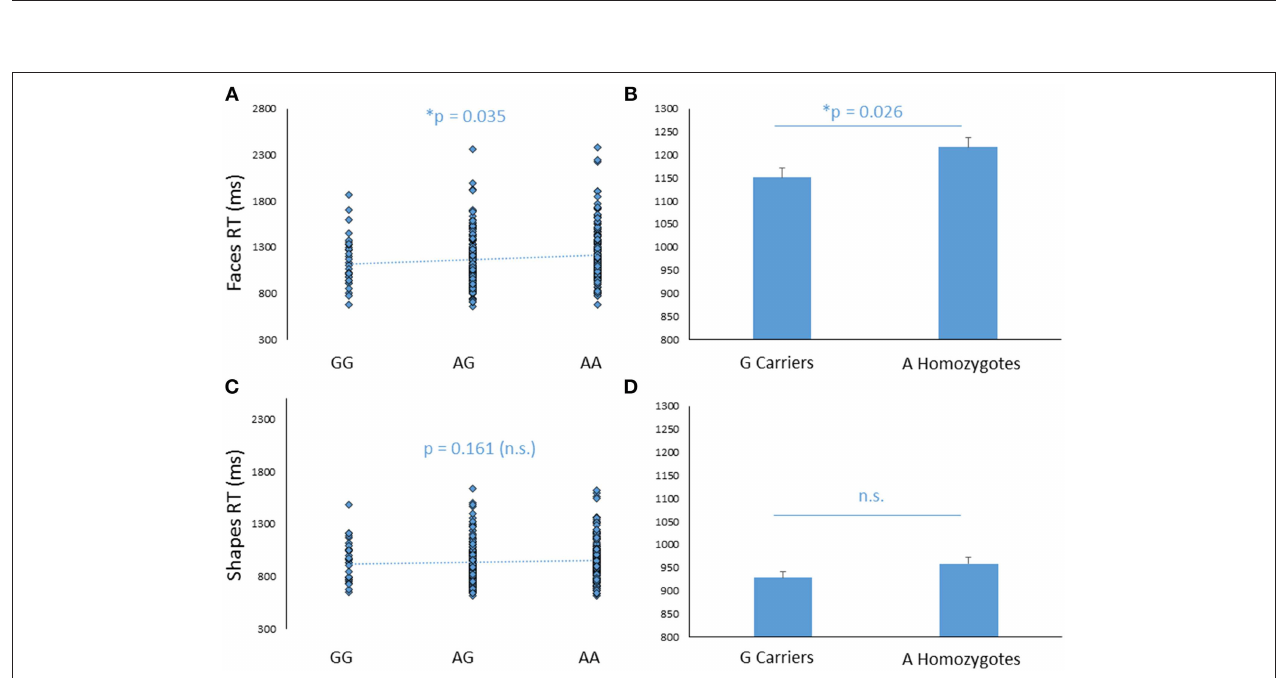
FIGURE 3 | Effects of FREM3 rs7676614 genotype on reaction times in the perceptual face matching task. Increasing number of A alleles was associated with slower reaction times in the Faces (A) , but not the Shapes (C) condition. These results were confirmed in a G allele dominant model, where A homozygotes showed slower reaction times than G carriers in the Faces (B) but not the Shapes condition (D) . Error bars represent standard error of the mean. * p < 0 . 05 , # p < 0 . 10 .